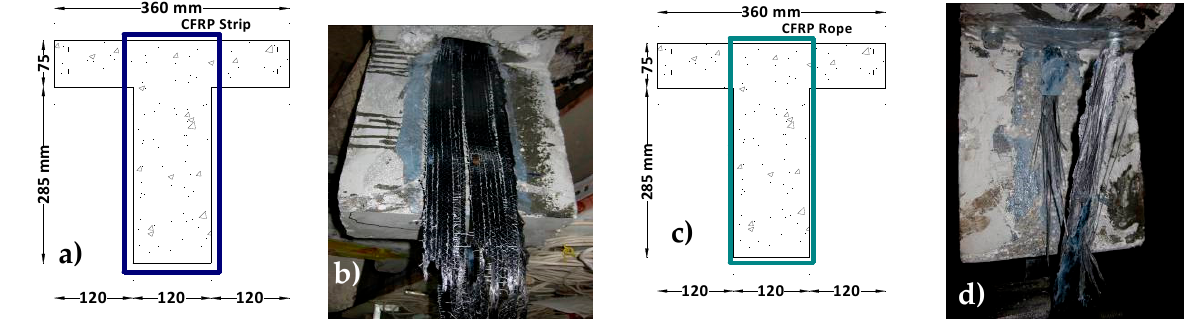
Figure 14. ( a ) “Unit T-beam” specimens CFRP strip Ref-1 and Ref-2. ( b ) Failure mode of specimen CFRP strip Ref-1. ( c ) “Unit T-beam” specimens CFRP Rope SWFX No1, No2 and No3. ( d ) Failure mode of specimen CFRP Rope SWFX No 2.